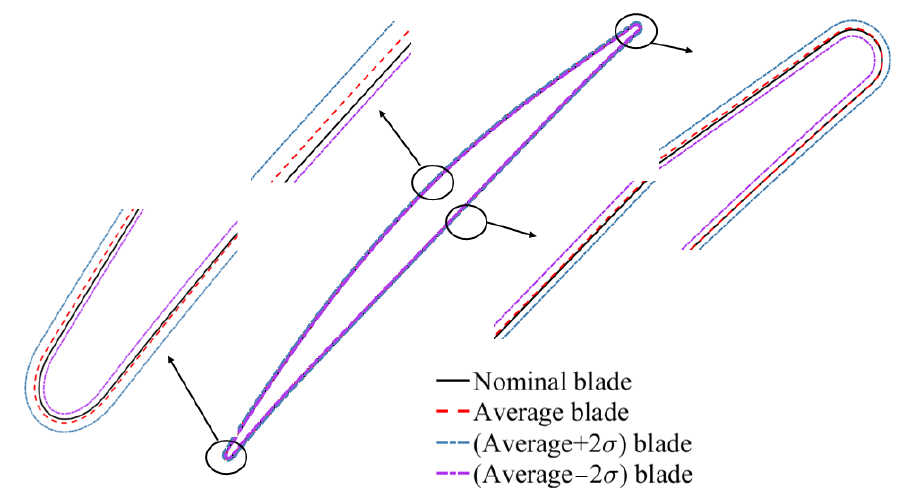
Figure 6. The nominal blade, average blade, and the average blades with twice the positive and negative standard deviation.